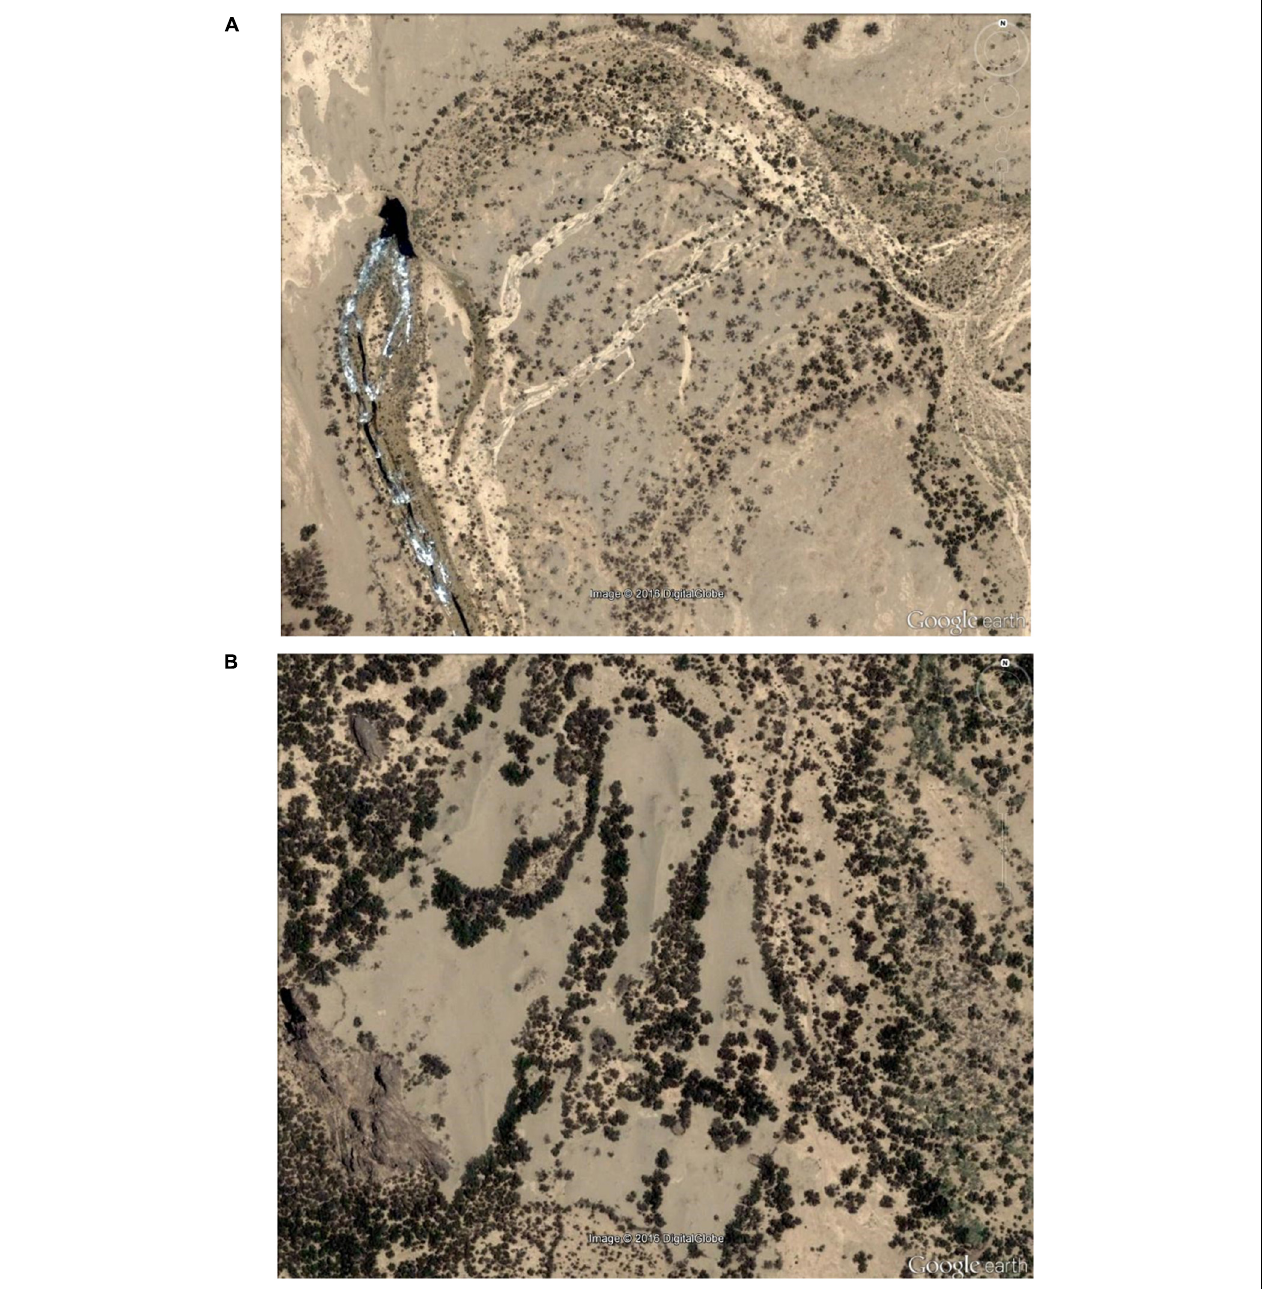
FIGURE 9 | Google Earth view of new populations of M. argun , as described by local trade travelers. The network of watercourses shapes their distribution. (A) In the image, M. argun palms with a flowing river in the location (the geographic coordinates: 21 ◦ 28 (cid:48) 49.66 (cid:48)(cid:48) N, 36 ◦ 05 (cid:48) 47.65 (cid:48)(cid:48) E). (B) Dense populations of M. argun . The two different shades of color indicate the presence of tree species other than palms in the same location, as also told by travelers (the geographic coordinates: 21 ◦ 30 (cid:48) 35.43 (cid:48)(cid:48) N, 36 ◦ 05 (cid:48) 18.53 (cid:48)(cid:48) E).